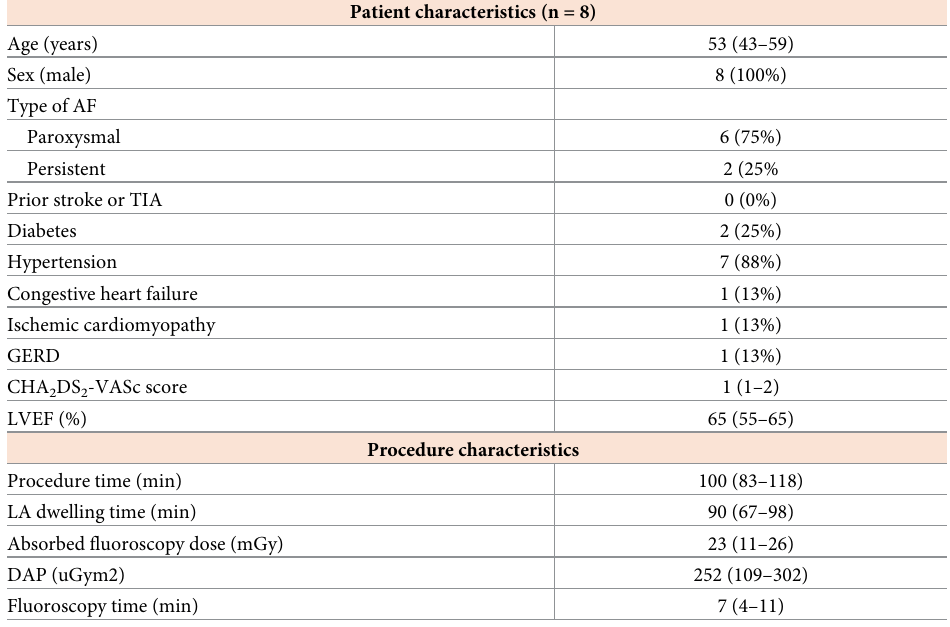
Table 1. Baseline characteristics of the study